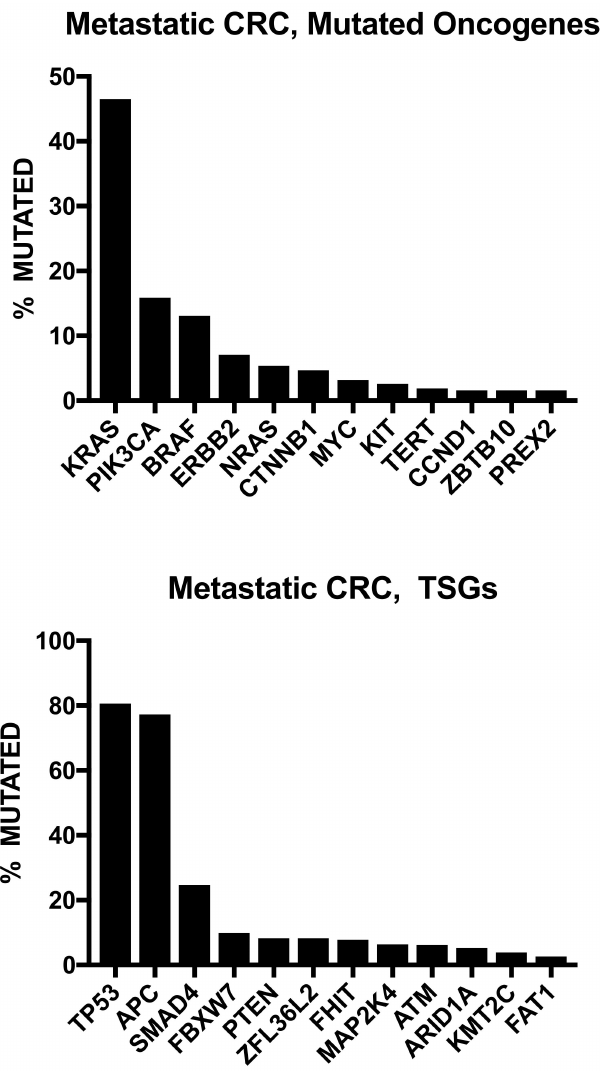
Figure 1. Frequency of the most recurrent gene alterations observed in metastatic CRC